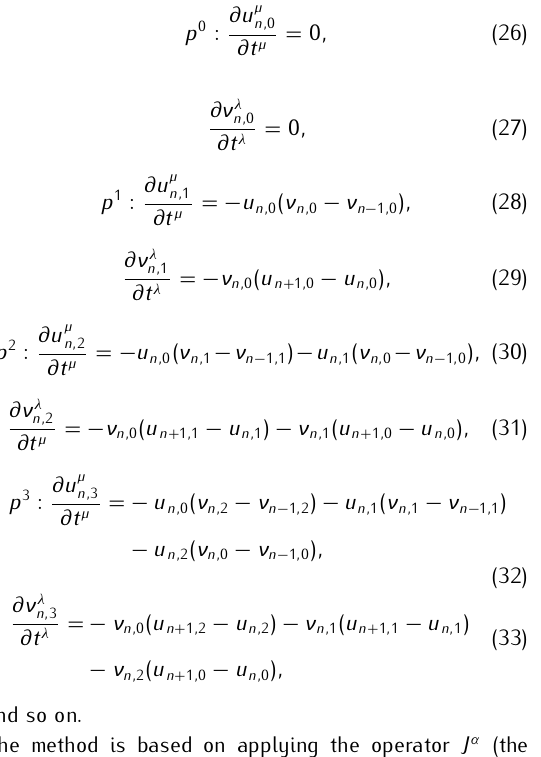
Figure 2. Explicit numerical solutions of Eq. (1) for ν